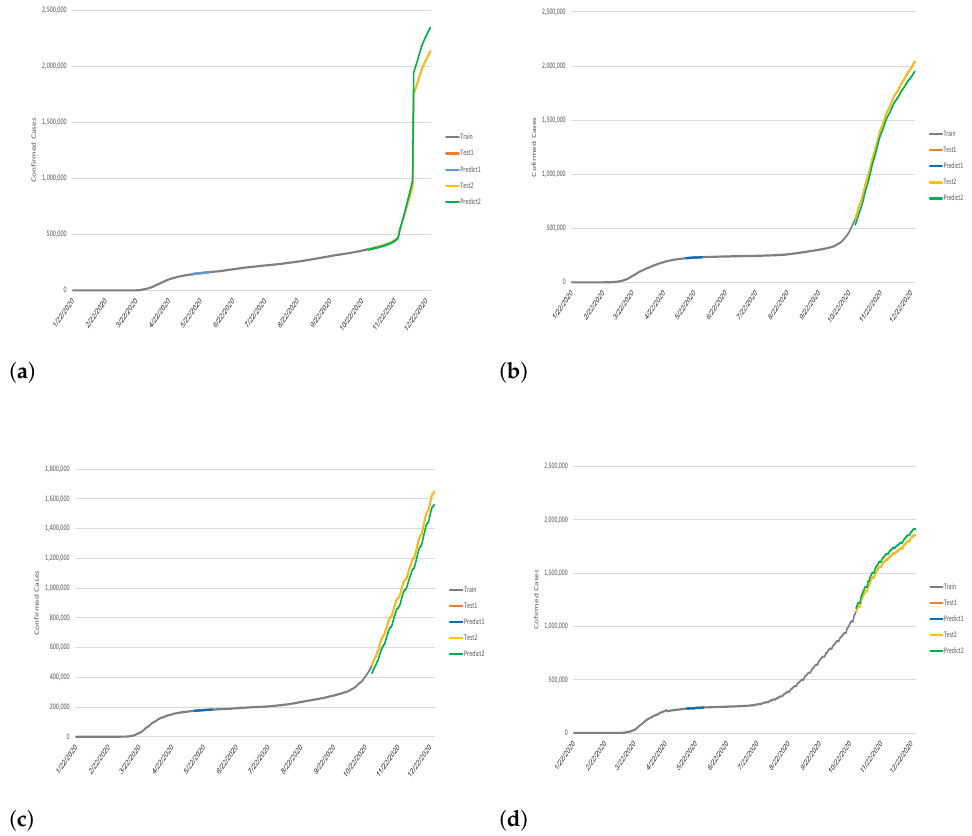
Figure 7. COVID-19 confirmed cases spread forecasting in several countries. ( a ) Turkey. ( b ) Italy. ( c ) Germany. ( d )